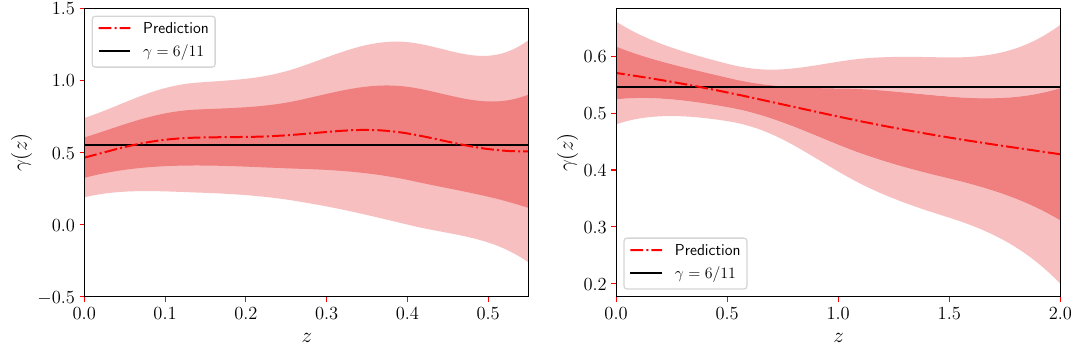
Fig. 4 Left panel: reconstruction of the γ( z ) function with the f ( z ) sample. Right panel: reconstruction of the γ( z ) function with the f σ 8 sample